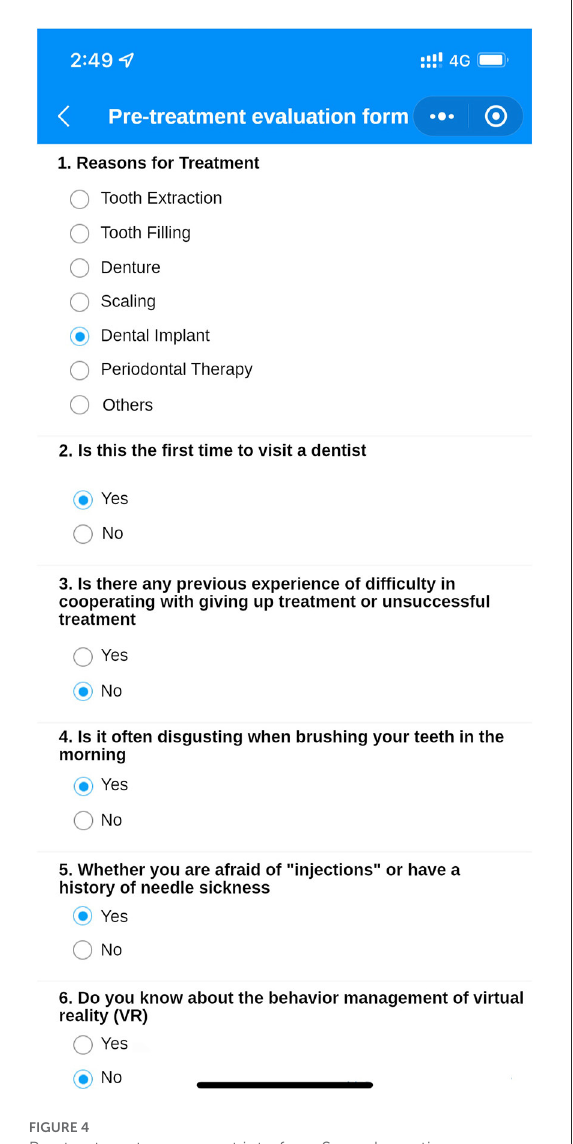
FIGURE3 Personal information interface. Patients can fill in their personal information (name, sex and age) and their past medical conditions and upload examination results for the doctor to evaluate in advance.